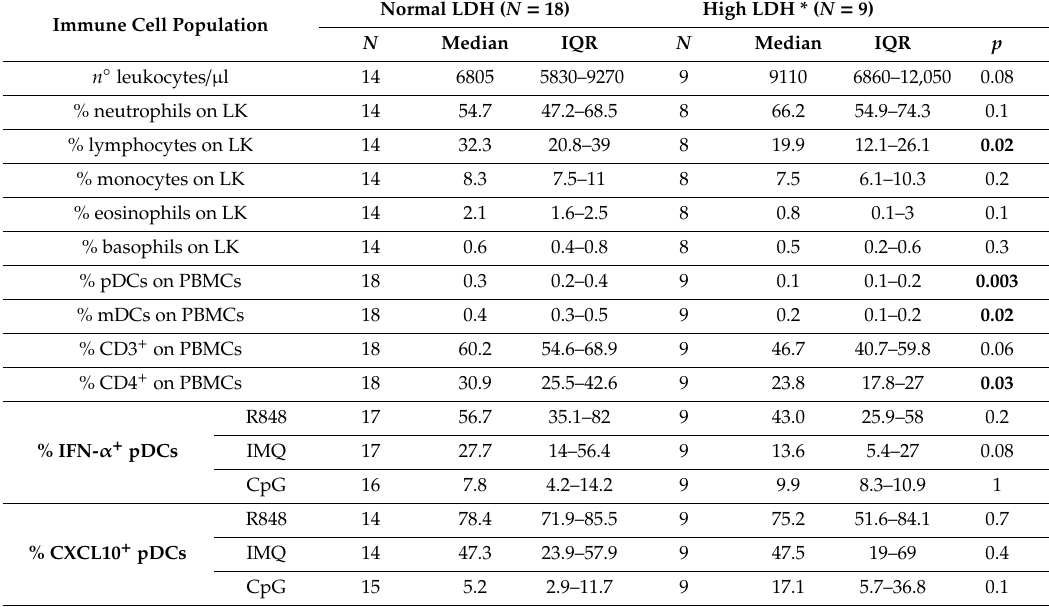
Table 3. Peripheral blood immune populations and lactate dehydrogenase (LDH) level in MM patients cohort at baseline (T0; N = 29).